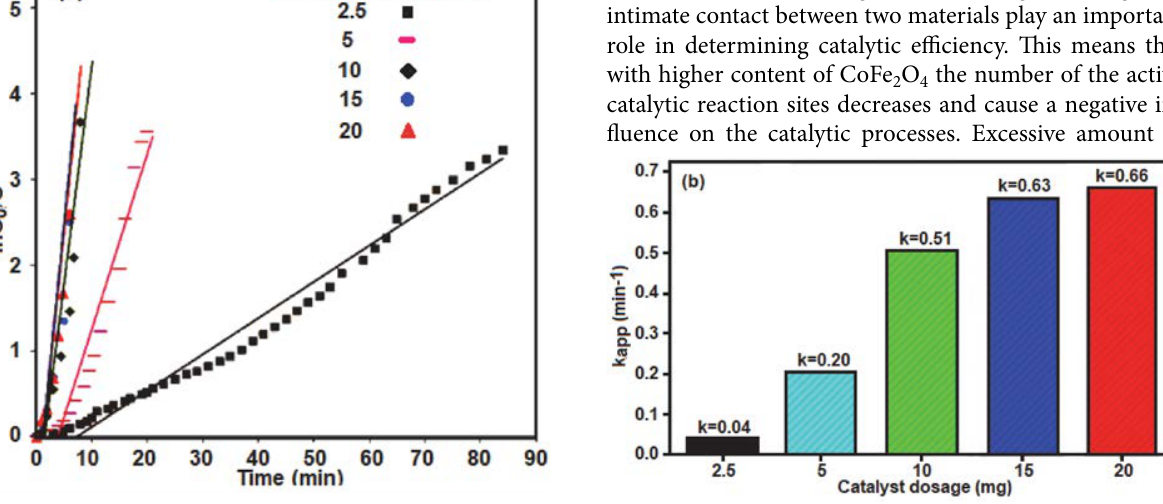
Figure 12 (a) Plot of ln (C 0 /C) against the reaction time in the presence of different amounts of Bi 2 O 2 CO 3 /CoFe 2 O 4 30% catalyst, and (b) the appar- ent rate constant values). Conditions: nitro compounds (2 mL, 0.2 mM) and NaBH 4 (0.5 mL, 20 mM), at 25 °C were used in all